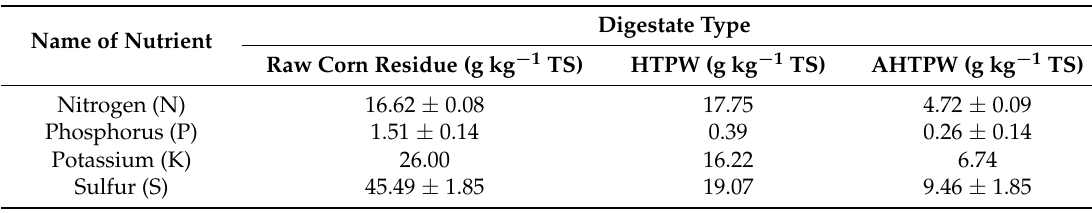
Table 4. Nutrient contents available for biofertilizer.